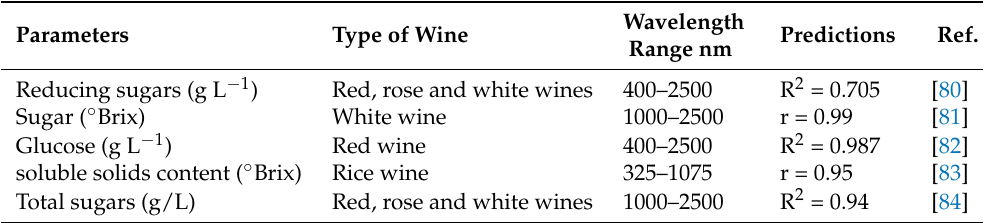
Table 7. Summary of sugar content in different wines using vis-NIR spectroscopy as reported in various research